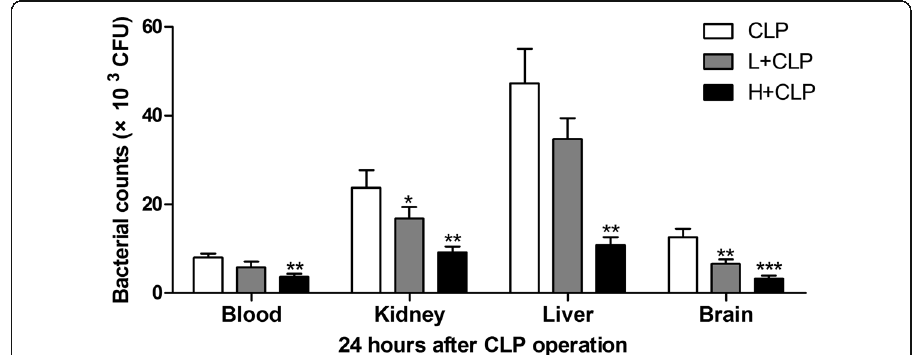
Fig. 2 The blood, kidney, liver and brain were collected, and bacterial counts were measured in CLP- induced septic mice. Values are expressed as mean ± SEM, n = 10 in H + CLP group and n = 8 in CLP or L + CLP group. * P < 0.05, ** P < 0.01, *** P < 0.001, versus S. aureus or CLP single treatment